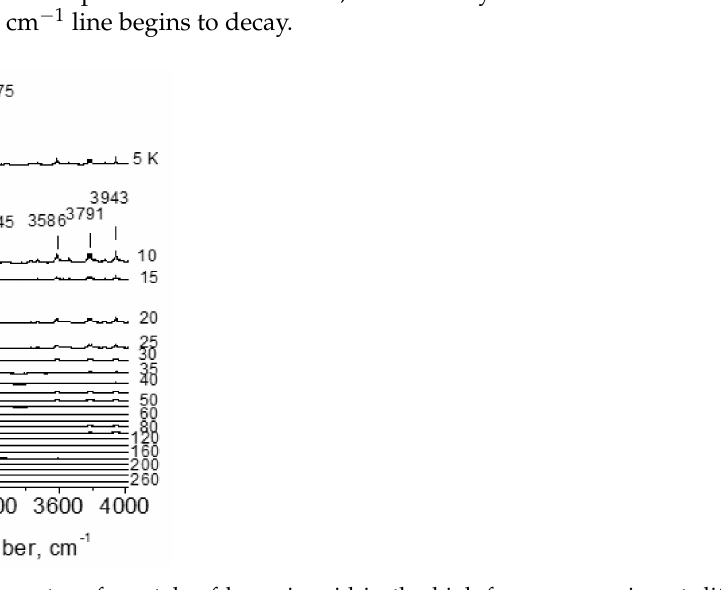
Figure 13. Raman spectra of crystals of benzoic acid in the high-frequency region at different temperatures [24].